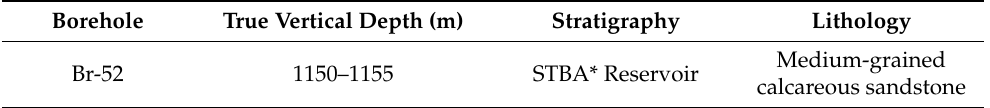
Table 1. The samples of reservoir rocks.